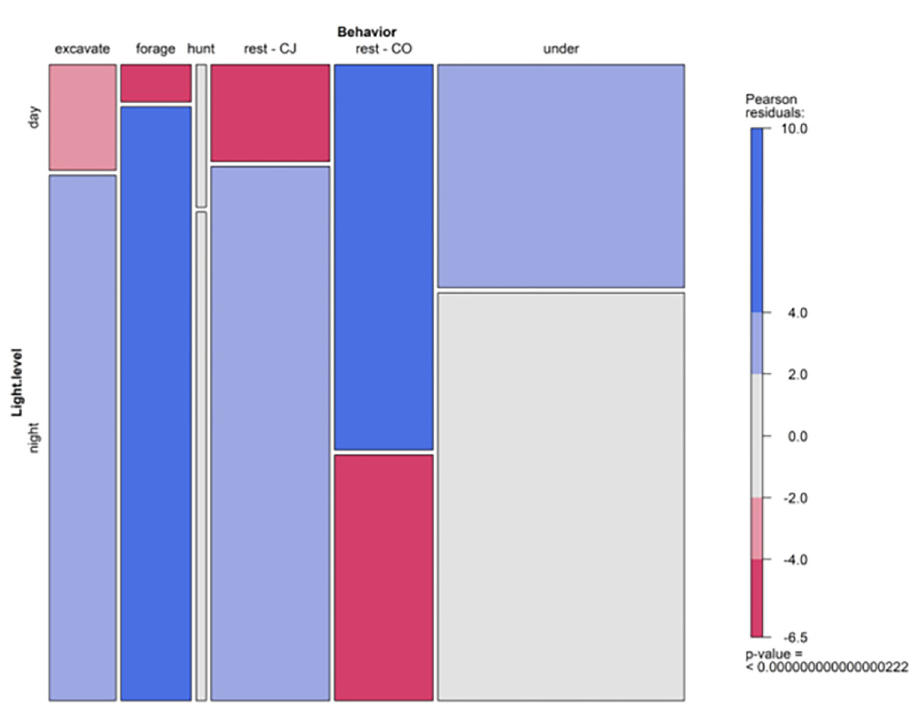
Fig 8. Mosaic plot of the behavior exhibited by each crayfish (excavate, forage, guard, hunt, relax, under) based on the time of day it was recorded (night, day). The width of the bars represents the number of observations that we recorded, whereas the height of the bars represents the proportion of observations that were recorded in the night (the bottom bar) versus the day (the top bar). The color of each bar represents whether the observed frequency of each behavior deviates from the expected frequencies if the variables were independent. Red denotes observed frequencies that are smaller than the expected frequency, whereas blue represents the observed frequencies that are larger than the expected frequencies. Gray represents a similar observed frequency when compared to the expected